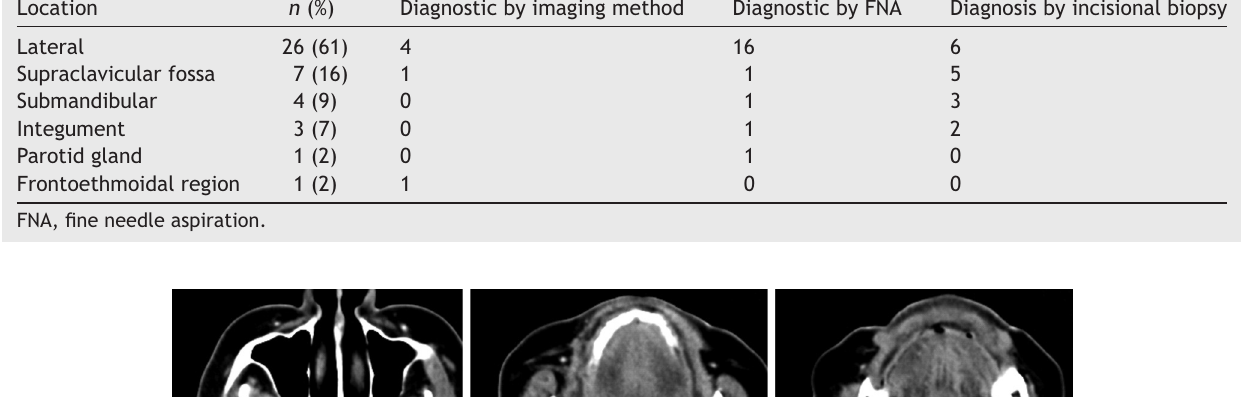
Anatomic site of 42 head and neck neurogenic tumors and diagnosis modality. Location n (%) Diagnostic by imaging method Diagnostic by FNA Diagnosis by incisional biopsy